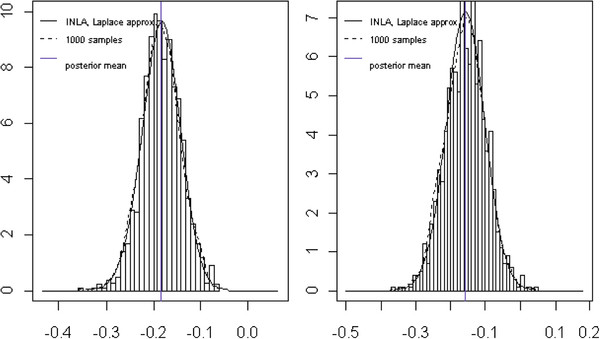
Simulation study: Variability of mean LS within different simulation scenarios. Variability of mean logarithmic score LSÂ¯(r) for true negative binomial (NB) compared with arcsinh, (zero-inflated) Poisson and zero-inflated NB model (r = 1,…,100 iterations per scenario). Sample size: n = 20,50,100 subjects per group; k = 0.5,1,5,10,20,50 determines the amount of overdispersion. Each row is a different value of k (amount of overdispersion), and each plot shows the mean LSÂ¯(r) for each competing model. The column of panels on the right has the largest sample size n; the top row exhibits the results for highly overdispersed counts (k=0.5).